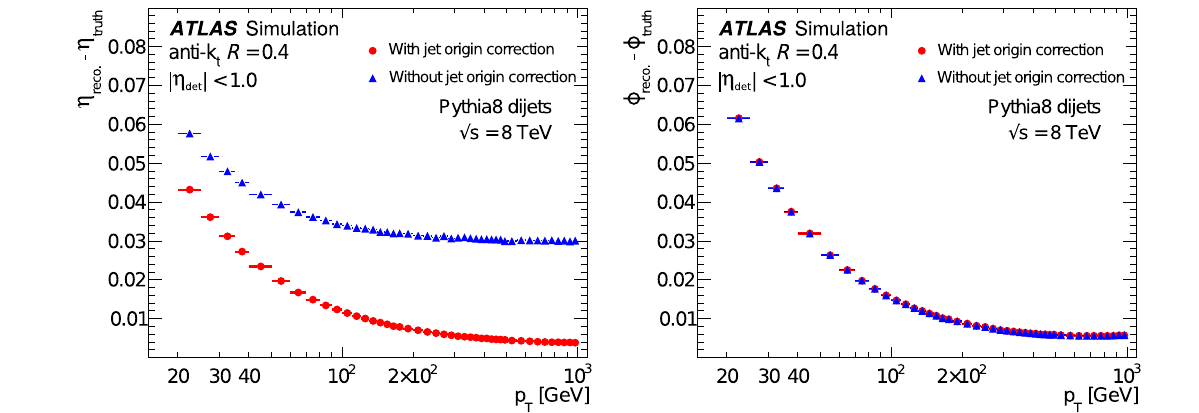
Fig. 2 Jet angular resolution as a function of transverse momentum for anti- k t jets with R = 0 . 4. The resolutions are defined by the spread of the difference between the reconstructed jet axis ( η reco ,φ reco ) and the axis of the matched truth-particle jet ( η truth ,φ truth ) (see Sect. 4.2 for